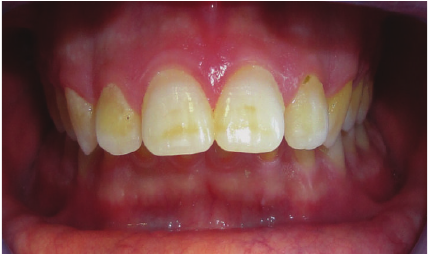
Figure 7: Grade III specific enamel defects in an ascertained coeliac patient (A Group). Symmetrical and chronological position on the following dental elements: